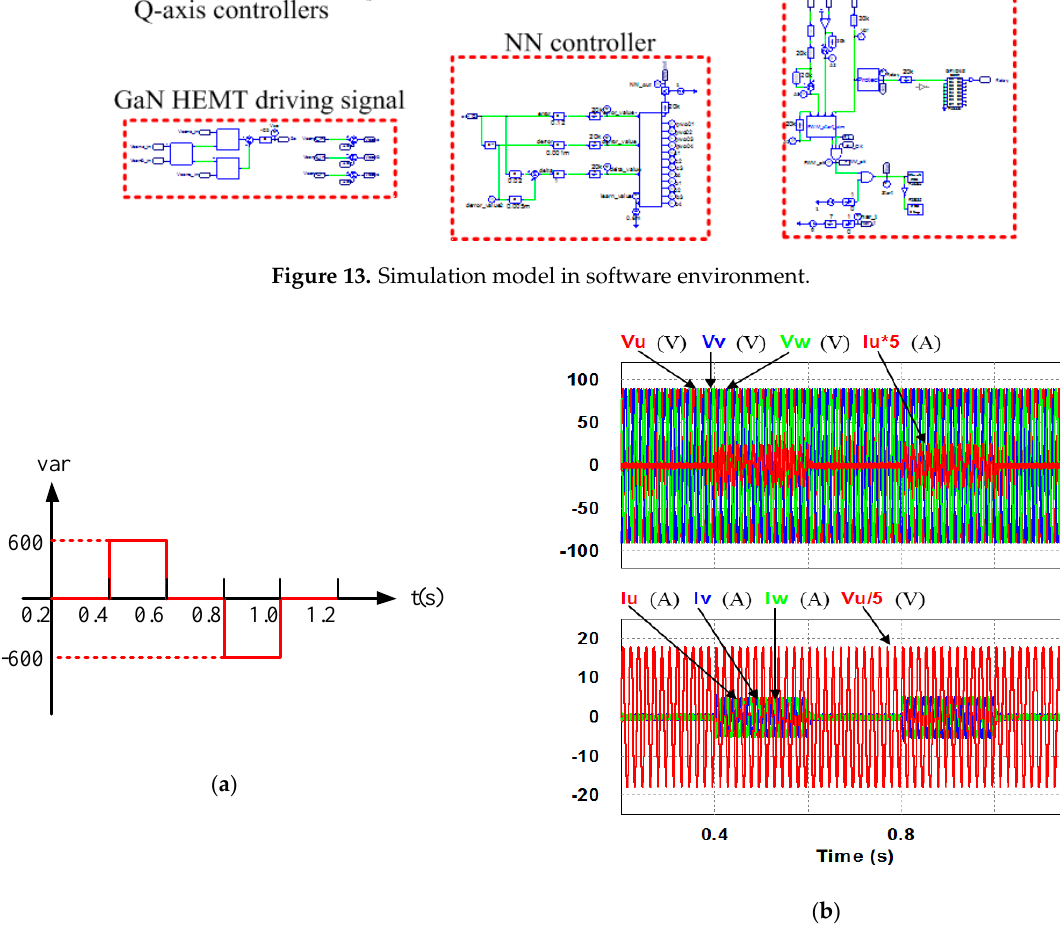
Figure 14. ( a ) Simulation scenario: sequence diagram of reactive power command; ( b ) case 1 simulation result: three-phase voltages and currents.